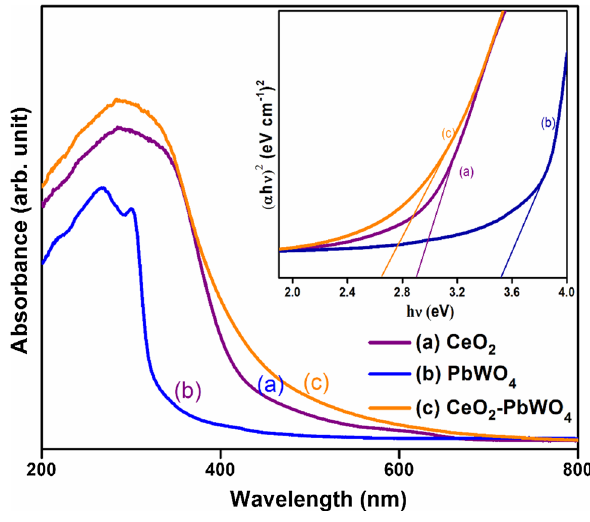
Fig. 6 a UV–Vis DRS absorption spectra b Tauc’s plots of the CeO PbWO 4 and CeO 2 /PbWO 4